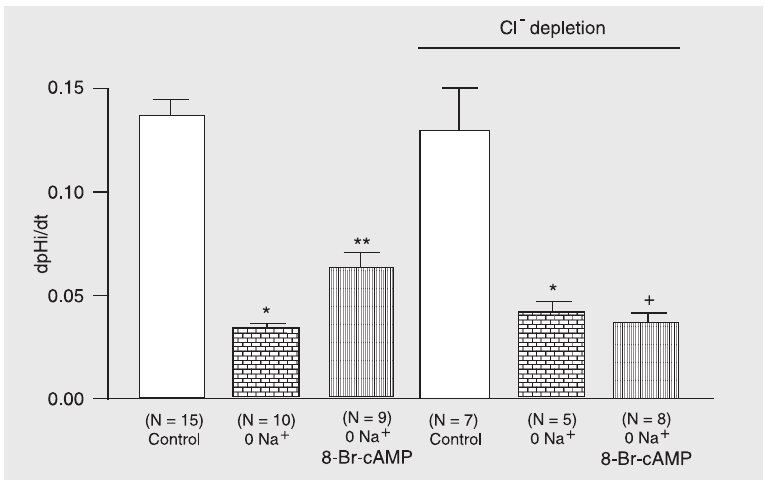
Figure 4. Effect of 10 µM 8-Br-cAMP on dpHi/dt in controls or 0 Na + Ringer solution in normal and Cl - -depleted C11 cells. *P < 0.01 vs control Na + . **P < 0.05 vs 0 Na + ; + P > 0.05 vs 0 Na + (ANOVA).